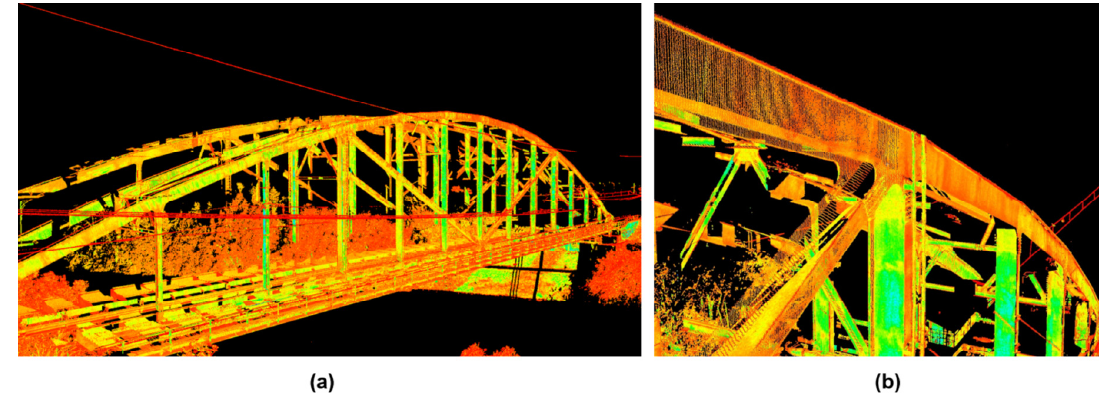
Figure 3. A point cloud as a result of the 3D laser scanning: ( a ) the global view; ( b ) in detail.